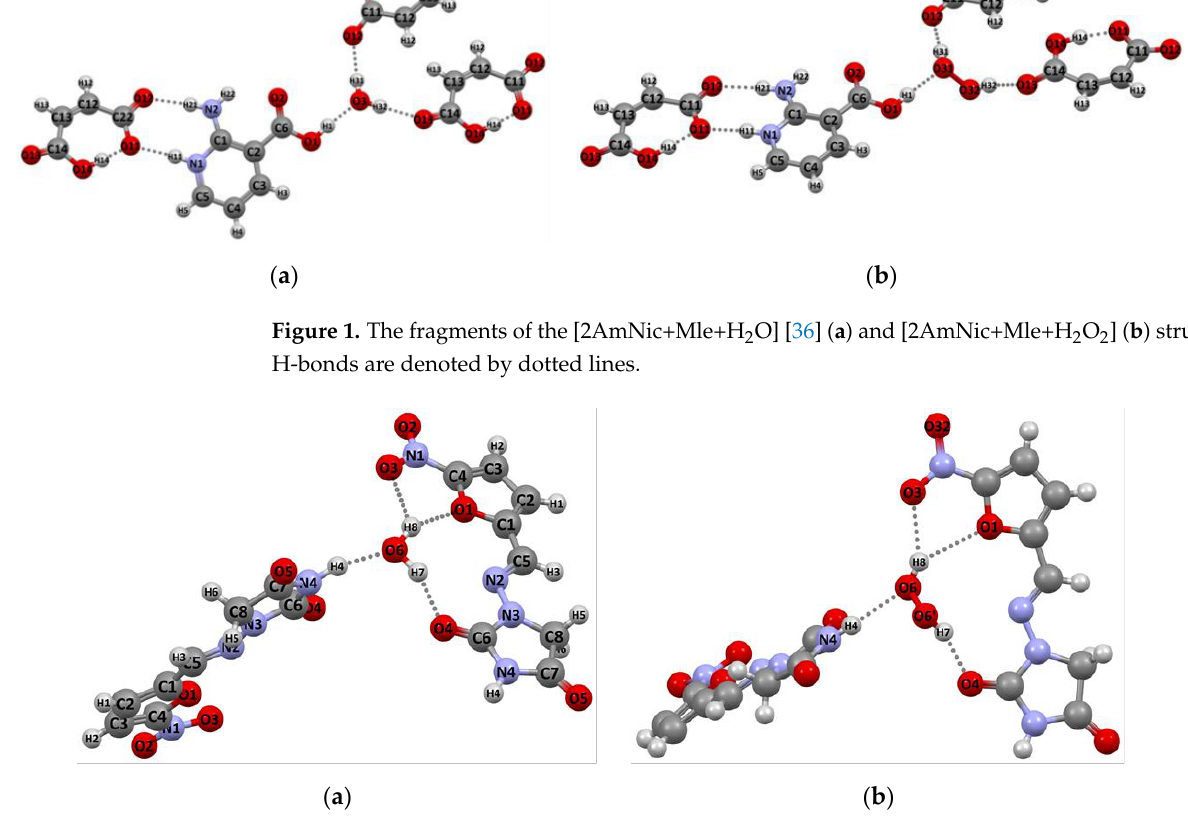
Figure 2. The fragments of the [NFA+H 2 O] [35] ( a ) and [NFA+H 2 O 2 ] ( b ) structures. H-bonds are denoted by dotted lines. Table 1. Distances between the atoms involved in the formation of intermolecular H-bonds in [2Am- Nic+Mle+H 2 O], [2AmNic+Mle+H 2 O 2 ], [NFA+H 2 O] and [NFA+H 2 O 2 ]; R (O ∙∙∙ N), R (O ∙∙∙ O), and R (H ∙∙∙ O) obtained using periodic DFT computations (PBE-D3/6- 31G**) and the ∆ H HB values evalu- ated using Equation (1).